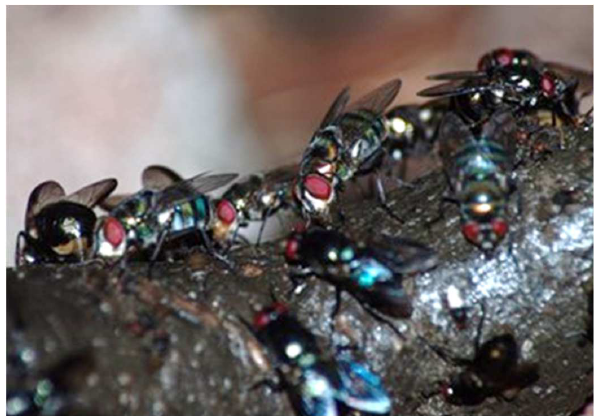
Figure 4. Flies feeding on the feces of a mangabey. Photo.courtesy of Jan Gogarten and the Tai Chim- panzee